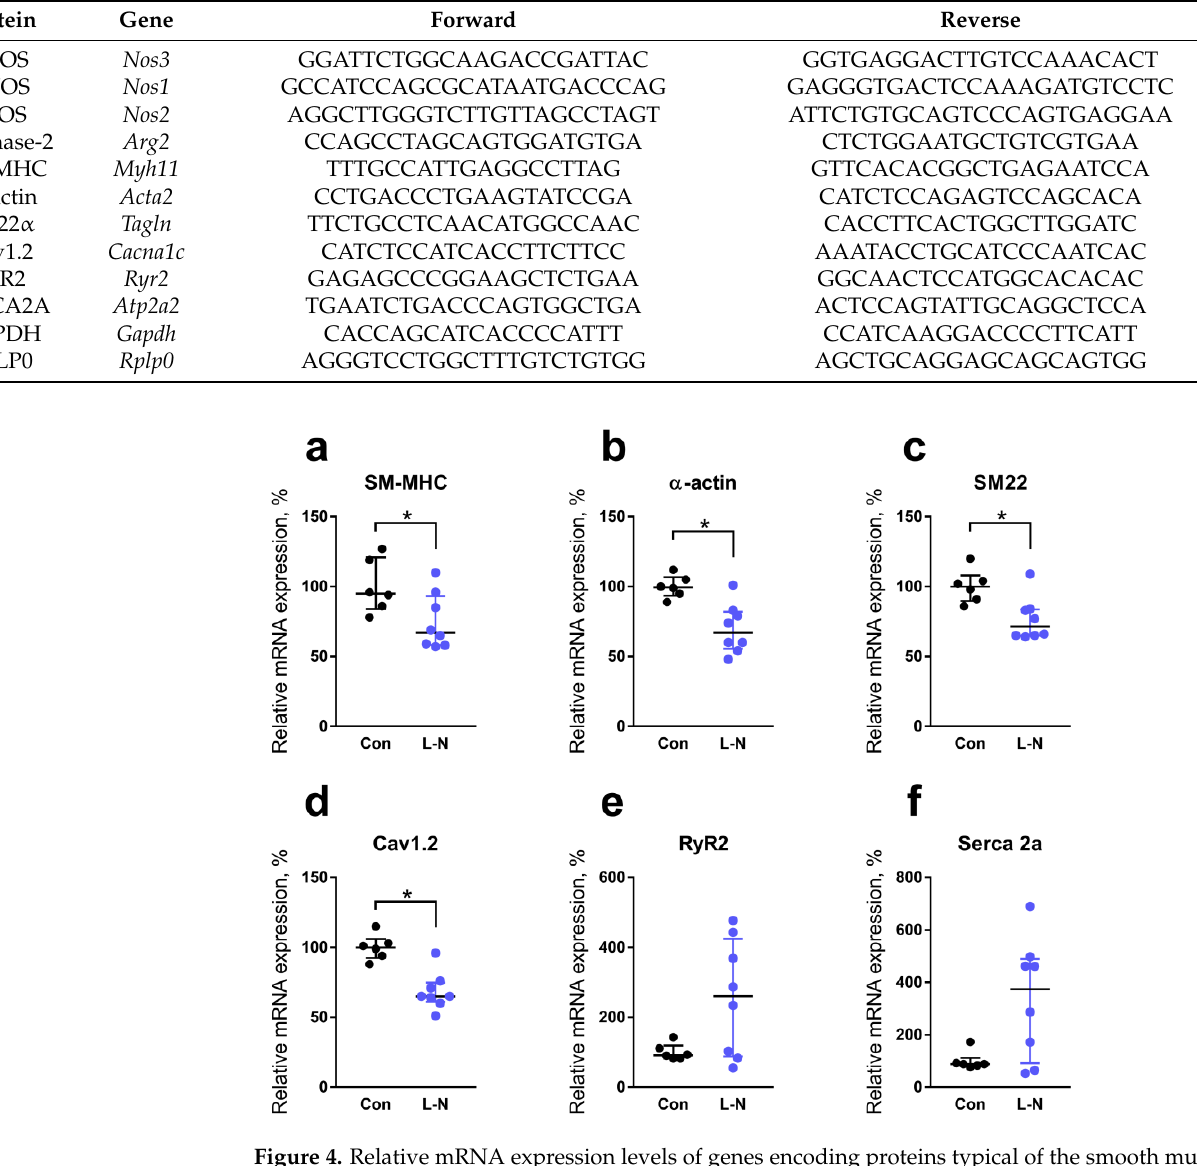
Table 3. Gene-specific primers used in qPCR.